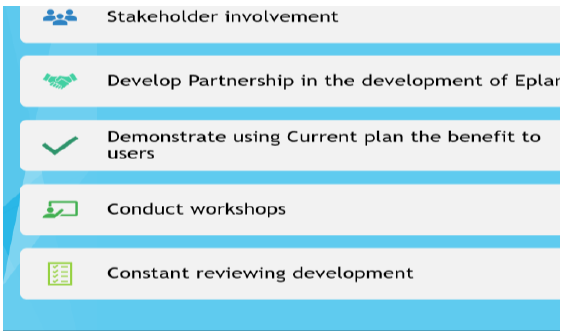
Figure 10 : Strategy to Improve